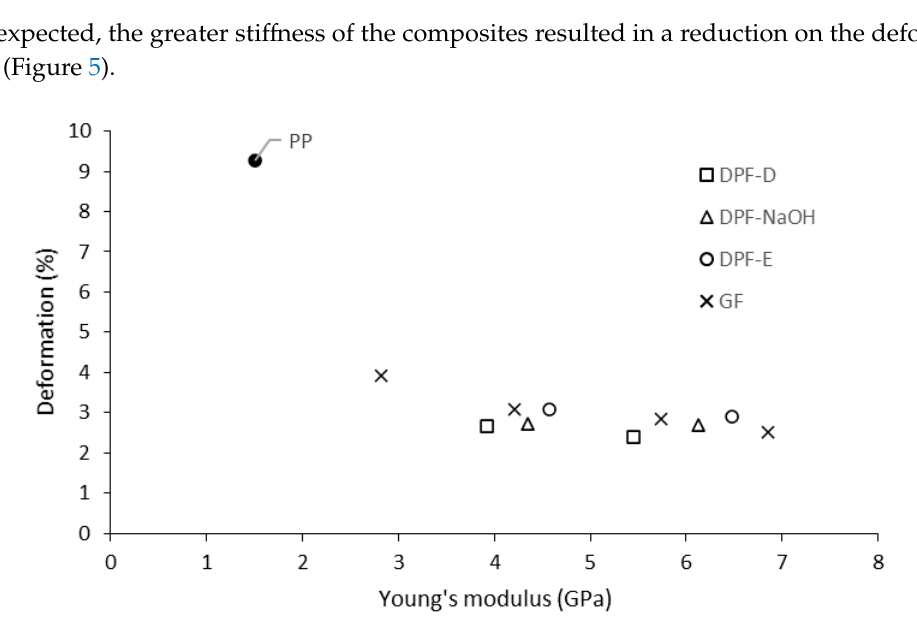
Figure 5. Evolution of the deformation with the Young’s modulus of the composites.